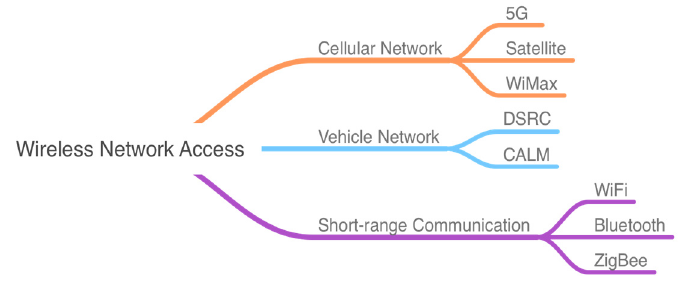
Figure 1. VANETs’ communication technologies.